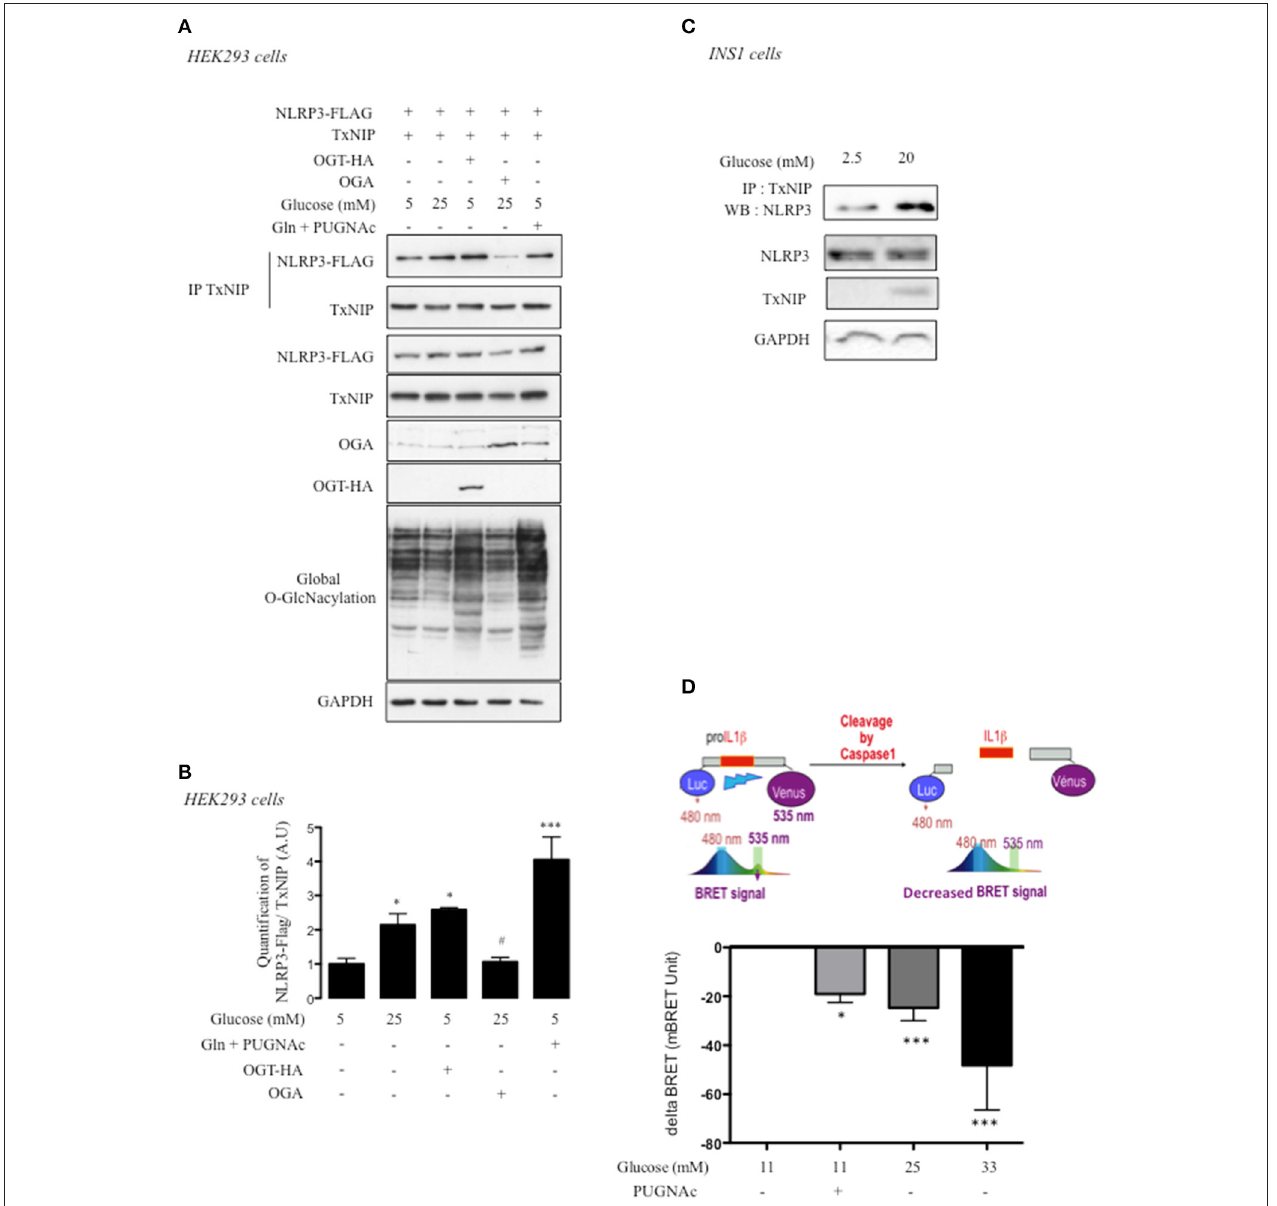
FIGURE 4 | O-GlcNAcylation promotes TxNIP interaction with NLRP3 and pro-Il1 β cleavage. (A) HEK293 cells were co-transfected with TxNIP, NLRP3-flag, OGT, and OGA plasmids and incubated for 24h under low glucose condition (5mM), high glucose condition (25mM), or low glucose condition supplemented with PUGNAc and glucosamine (Gln). Immunoprecipitation (IP) of TxNIP was analyzed by immunoblotting with a Flag antibody. Representative Western blot for NLRP3, TxNIP, OGA, and OGT protein content are shown n = 4–7 independent experiments. GAPDH was used as loading control. (B) Quantification of the interaction between TxNIP and NLRP3 normalized to total TxNIP protein. Significance is based on two-way ANOVA followed by a Bonferroni post-hoc test. * p < 0.05, *** p < 0.001 when compared to 5mM glucose; # p < 0.05 when compared to 25mM glucose. (C) INS1 832/13 cells were stimulated for 24h under low glucose (2.5mM) or high glucose (20mM) concentrations supplemented with PUGNAc. Immunoprecipitation (IP) of TxNIP was analyzed by immunoblotting with a NLRP3 antibody. Representative Western blot for NLRP3 and TxNIP protein content are shown. GAPDH was used as loading control ( n = 4–7 independent experiments). (D) INS1 832/13 cells were transfected with a BRET-based biosensor that monitors pro-Il1 β cleavage. The histogram shows the decreased in BRET signal measured in INS1 832/13 cells after 24h of incubation with PUGNAc or with 25mM or 33mM of glucose. Significance is based on two-way ANOVA followed by a Dunnett’s test for BRET experiments. * p < 0.05, *** p < 0.001 ( n =